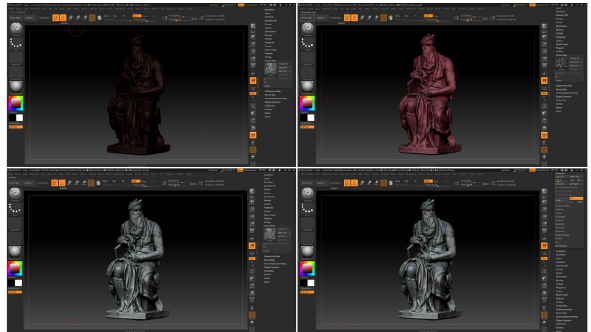
Figure 7. On the left, triangular model made up of 6 ML of triangular polygons. On the right, a retopologized model consisting of 57646 quadrangular polygons